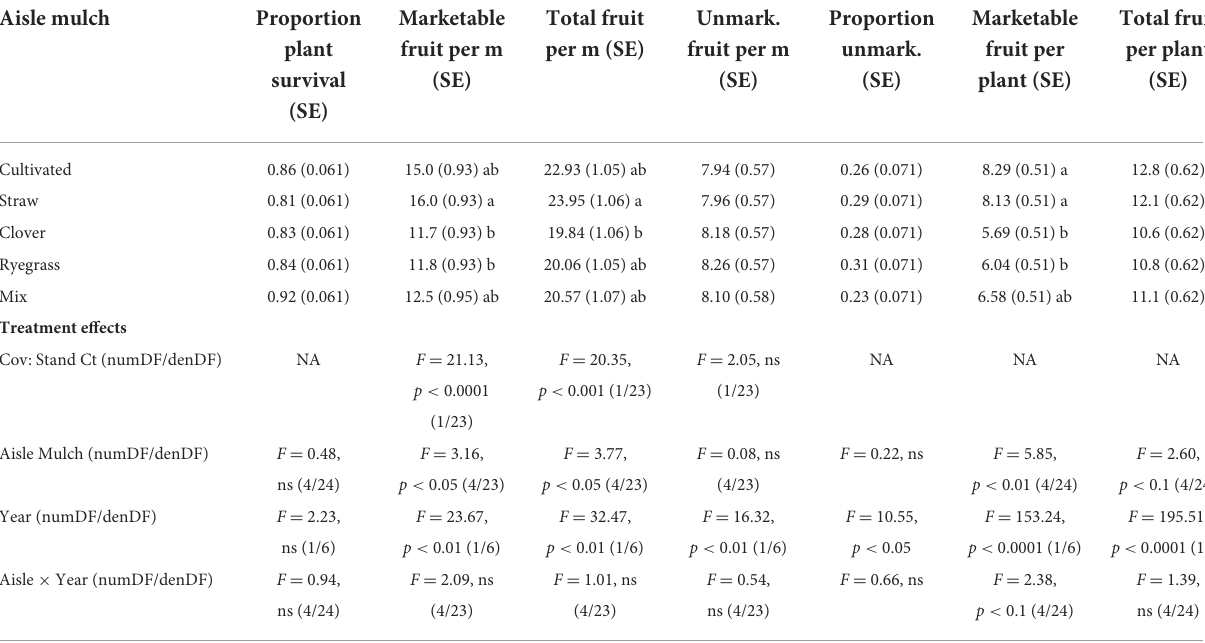
TABLE 3 Cumulative yield, fruit quality, and survival data of organic zucchini by living mulch treatment. Aisle